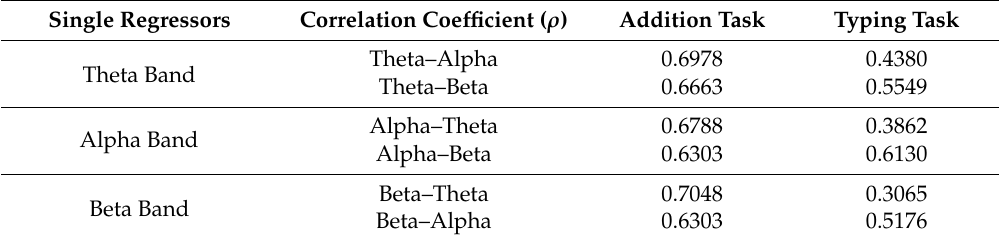
Figure 2. The topoplots represent the correlation R 2 maps between the brain power spectral densities and office task performance. Table 4. Correlation coefficients ( ρ ) between brain band pairs corresponding to the EEG electrodes with highest R 2 single regressor linear